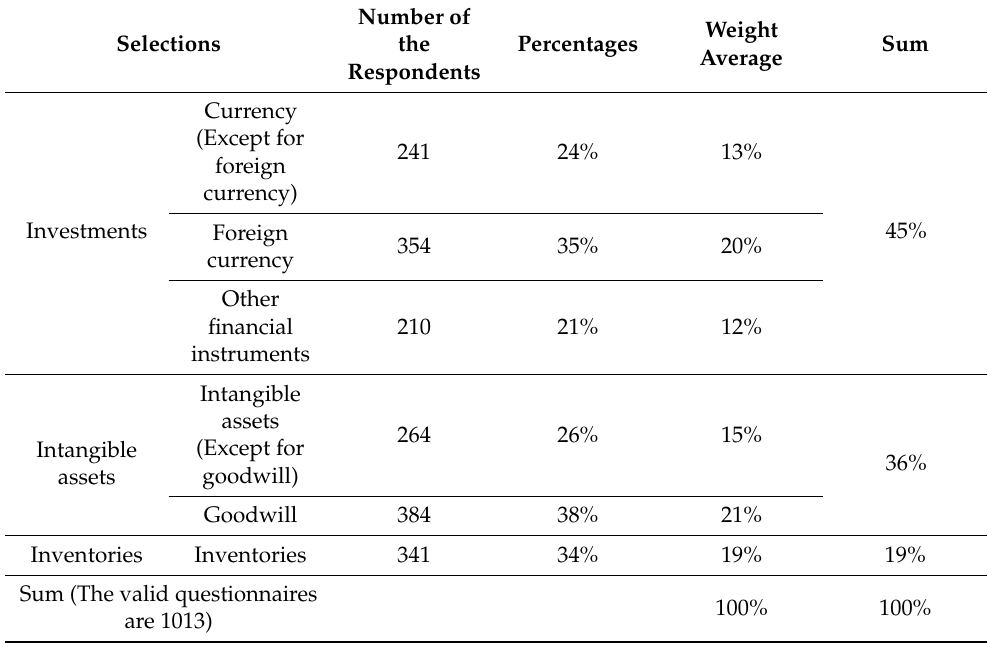
Table A9. How companies to account for holdings of cryptocurrencies (multiple-choice